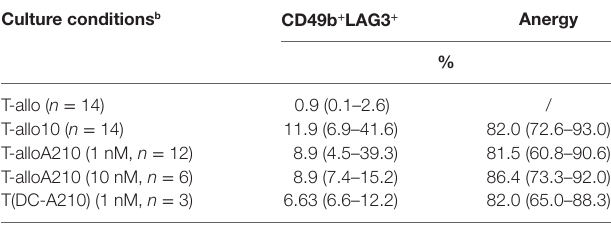
TaBle 1 | Percentage a of CD49b + LAG3 + and anergy in T cells. culture conditions b cD49b + lag3 +